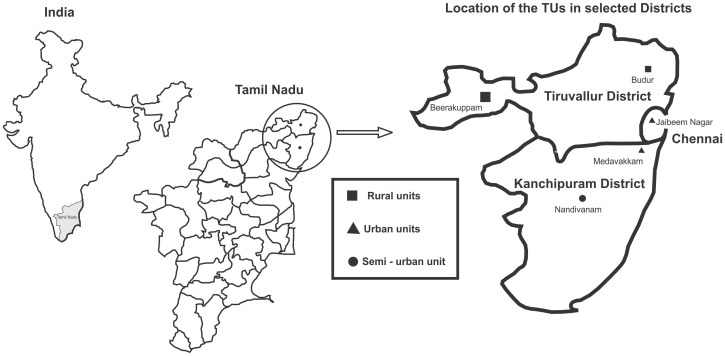
Location of selected Tuberculosis Units in three districts of Tamil Nadu, India.